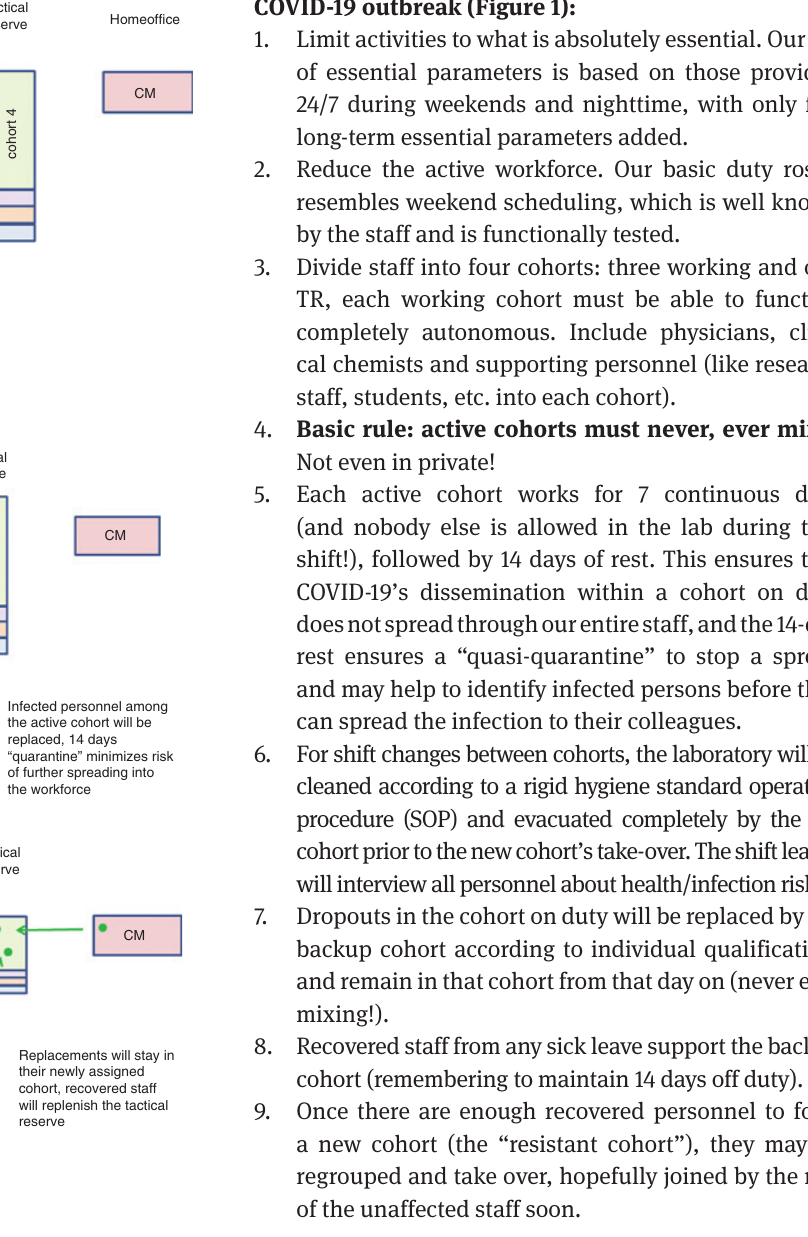
Outline for emergency planning in a clinical labora- tory to maintain long-term functionality during a COVID-19 outbreak (Figure 1):